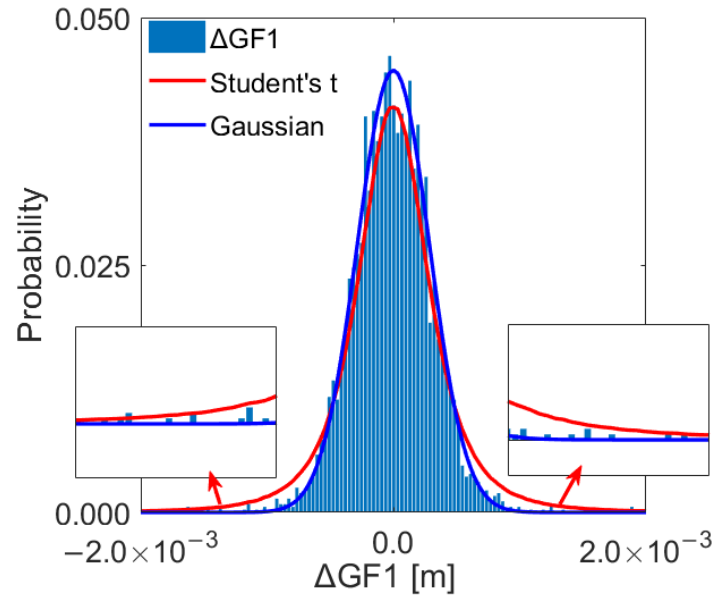
(cid:16) (cid:16) (cid:17)(cid:17) ∆ GF s 0,var , and Student’s t PDF (DOF = (cid:3045)(cid:3046) (cid:3439)(cid:4673) , and Student’s t PDF ( DOF (cid:3404) 3 ). Figure 3. ∆ GF s 1, k , r PDF of G08, N 1, k , r (cid:2869) , (cid:3038) ,